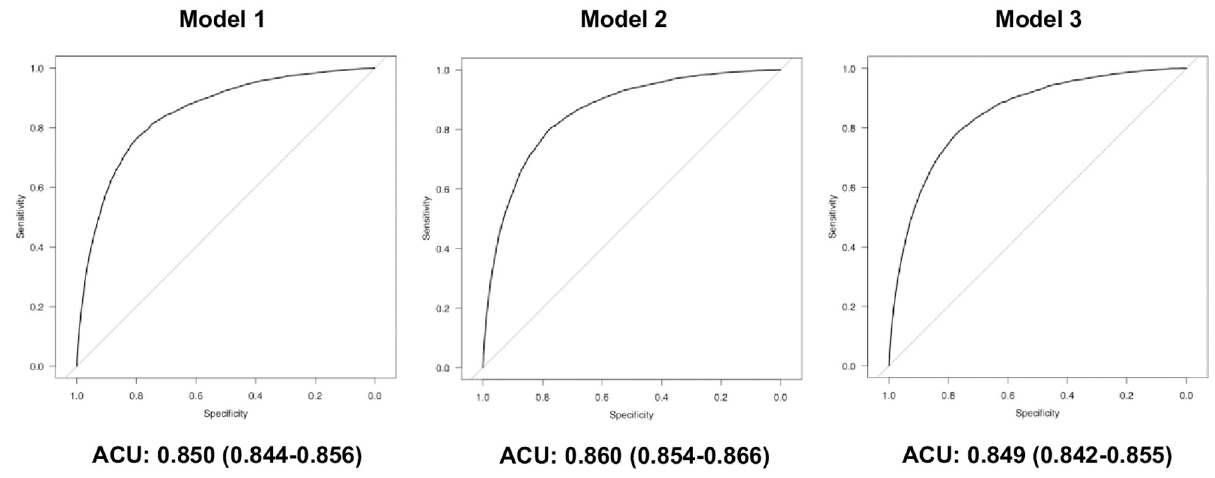
Fig 4. ROC curves for each model to predict hospital